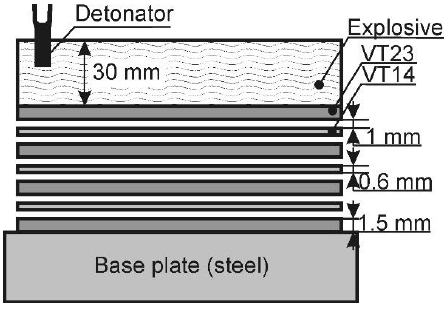
Figure 1. Scheme of the explosive welding of the seven-layer composite. Table 1. The elemental composition of initial materials, wt %.